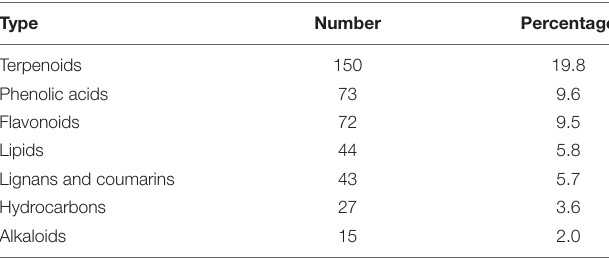
TABLE 1 | Classification and quantity of differential metabolites between BcR and BsR